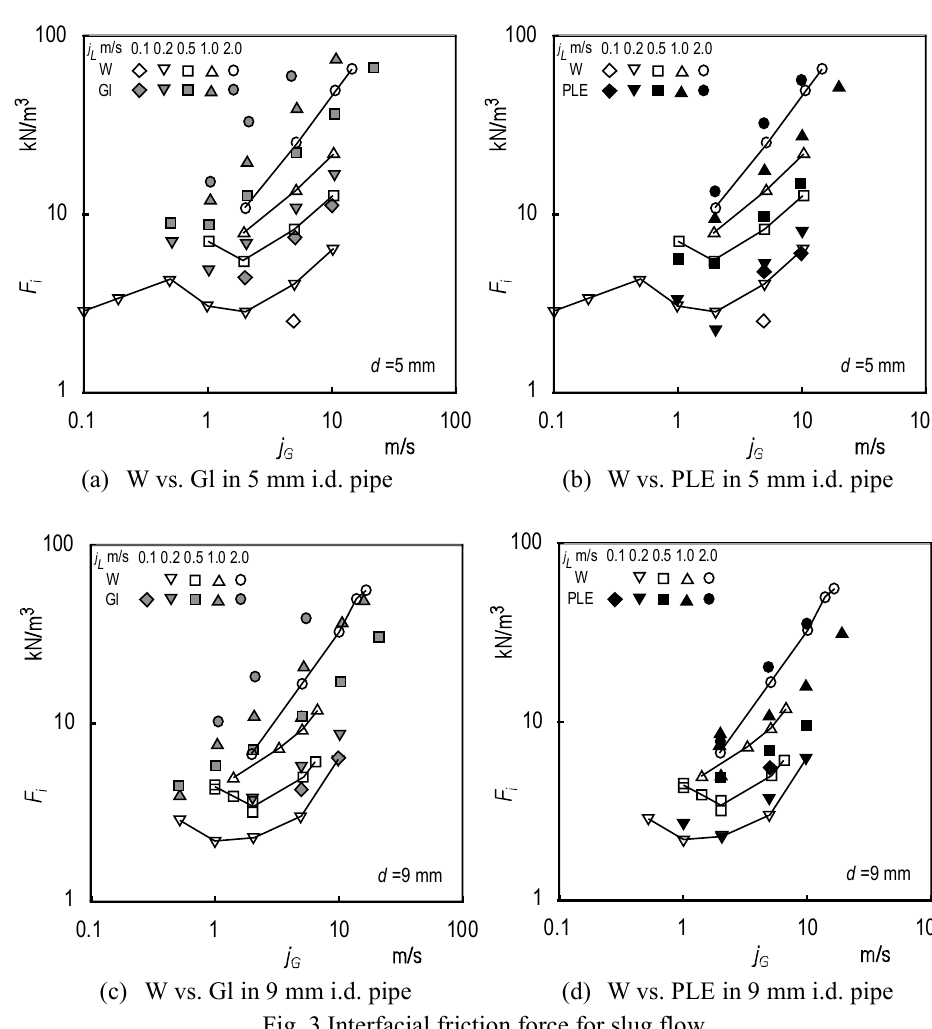
Fig. 3 Interfacial friction force for slug